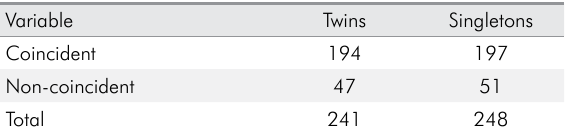
Table 2. Occurrence of coincident (repeated) palatal rugae in twins and